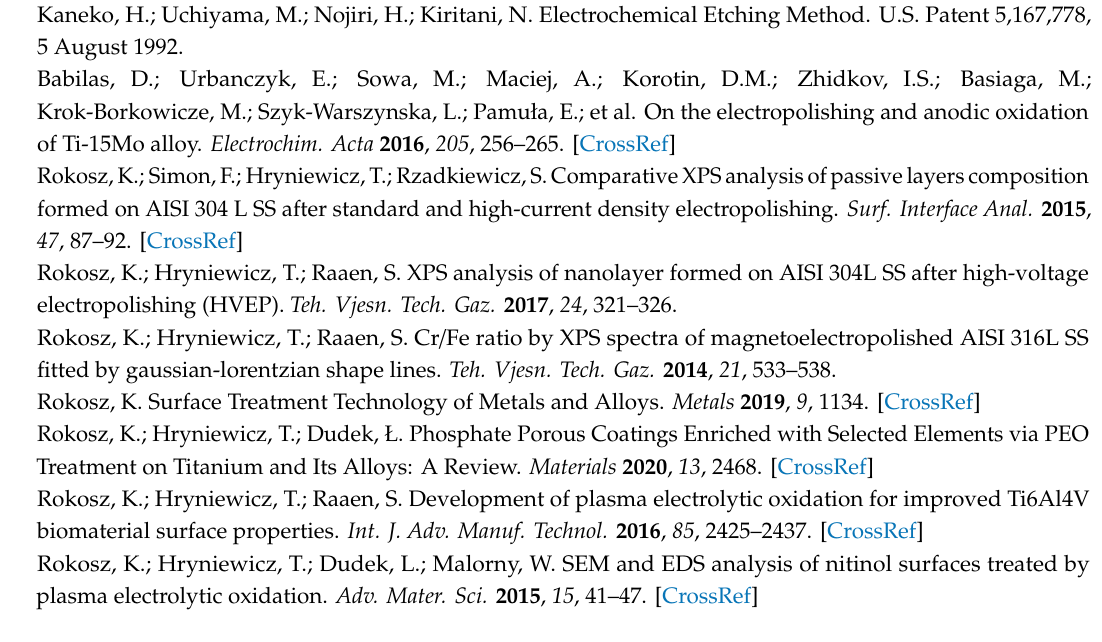
Figure S1: EDS spectra of coatings obtained at applied voltage of + 400 | − 35 V and + 400 | − 135 V, Table S1: Results of XPS analysis of PEO coatings in atomic percentage, Table S2: Maxima of binding energies (eV) of PEO coatings, Figure S2: XPS spectra of coatings enriched in zinc and copper, obtained at applied voltage of + 400 | − 35 V, Figure S3: XPS spectra of coatings enriched in zinc and copper, obtained at applied voltage of + 400 | − 135 V, Figure S4: XPS spectra of coatings enriched in zinc, copper, and calcium, obtained at voltage of + 400 | − 35 V, Figure S5: XPS spectra of coatings enriched in zinc, copper, and calcium, obtained at voltage of + 400 | − 135 V, Figure S6: XPS spectra of coatings enriched in zinc, copper, and magnesium, obtained at voltage of + 400 | − 35 V, Figure S7: XPS spectra of coatings enriched in zinc, copper, and magnesium, obtained at voltage of + 400 | − 135 V, Figure S8: Elemental composition by XPS of top 10 nm of coatings enriched in copper and zinc, obtained at voltage of: (a) + 400 | − 35 V, (b) + 400 | − 135 V, Figure S9: Elemental compositions by XPS of top 10 nm of coatings enriched in copper, zinc, and calcium, obtained at voltages of: (a) + 400 | − 35 V, (b) + 400 | − 135 V, Figure S10: Elemental composition by XPS of top 10 nm of coatings enriched in copper, zinc, and magnesium, obtained at voltages of: (a) + 400 | − 35 V, (b) + 400 | − 135 V, Table S3: Binding energies (BE, eV) of selected chemical compounds